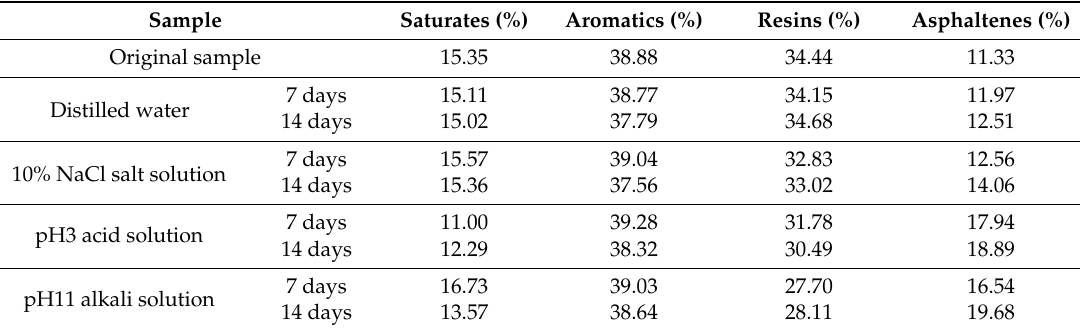
Table 2. Component fractions of 70 # asphalt before and after water solute immersion test.